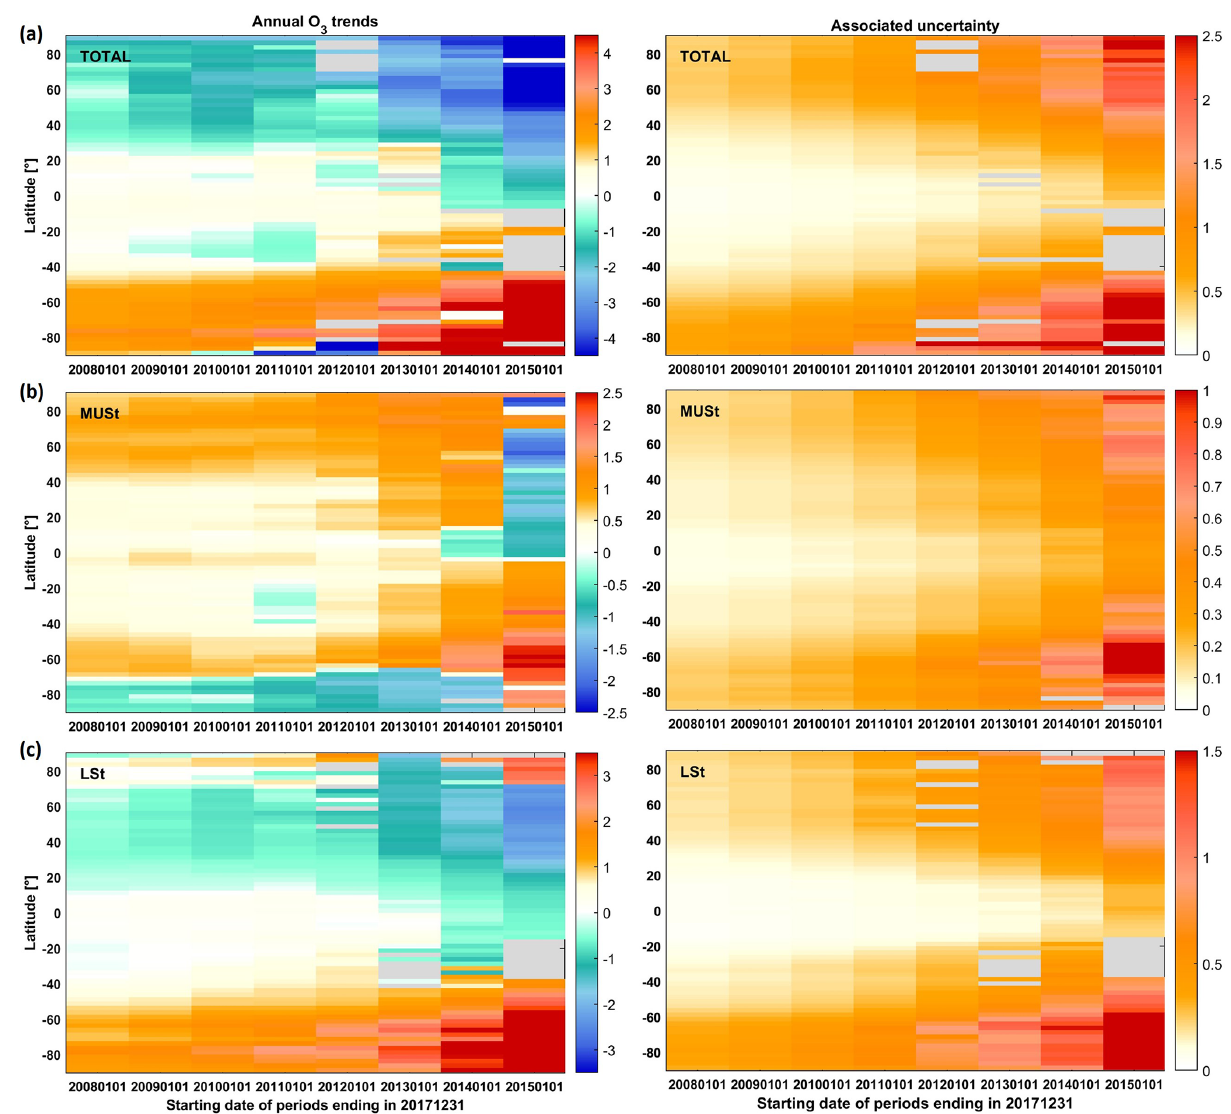
Figure 12. Evolution of estimated linear trend (DUyr − 1 ) and associated uncertainty accounting for the autocorrelation in the noise residuals (DUyr − 1 ; within the 95% confidence level) in (a) total, (b) MUSt and (c) LSt O 3 columns, as a function of the covered IASI measurement period ending in December 2017, with all natural contributions estimated from the whole IASI period (2008–2017; date format in the figure is yyyyddmm). Note that the scales are different between the